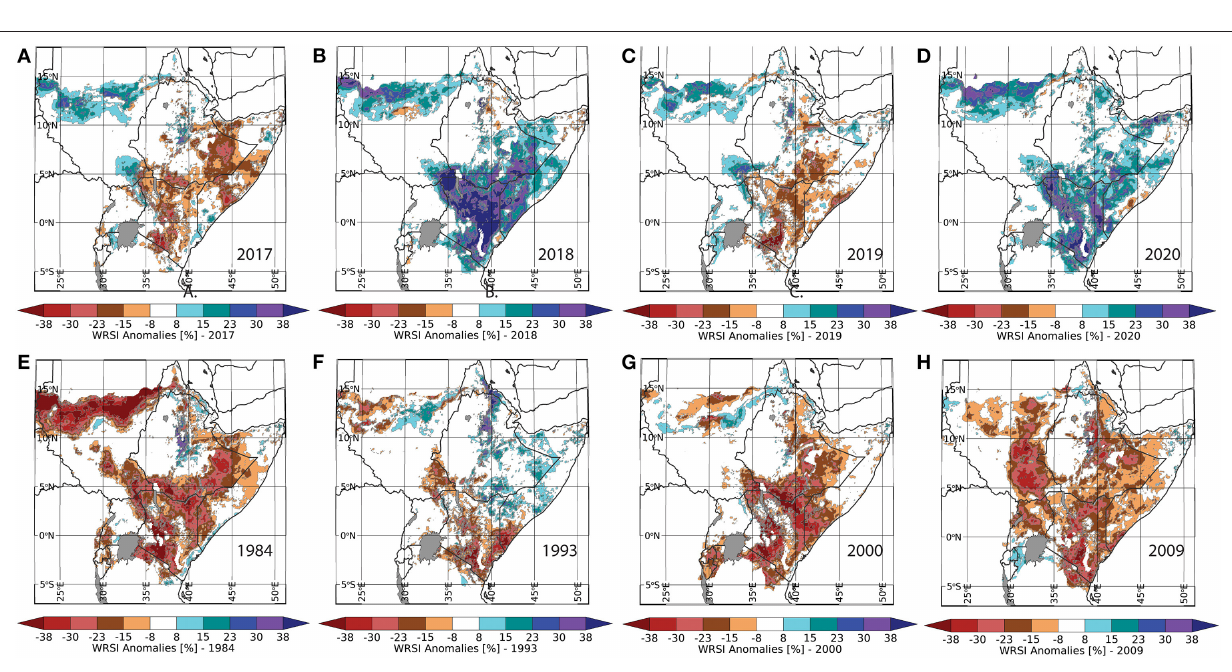
presents a very different story, with 2018 and 2020 values of 89 and 87. While these values are extremes in both time-series, the physical implications of these values are quite distinct. A WRSI value of about 88 indicates good cropping conditions.